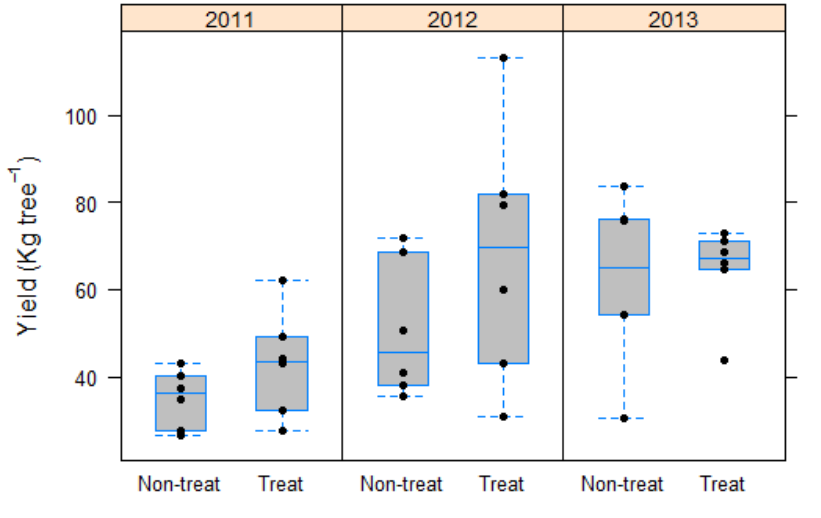
Figure 4. Box-whisker plots of yield of trees treated with fenbuconazole and the non-treated control in experiment 1 on ’Star Ruby’ grapefruit at Tambo, Panama, from 2011 to